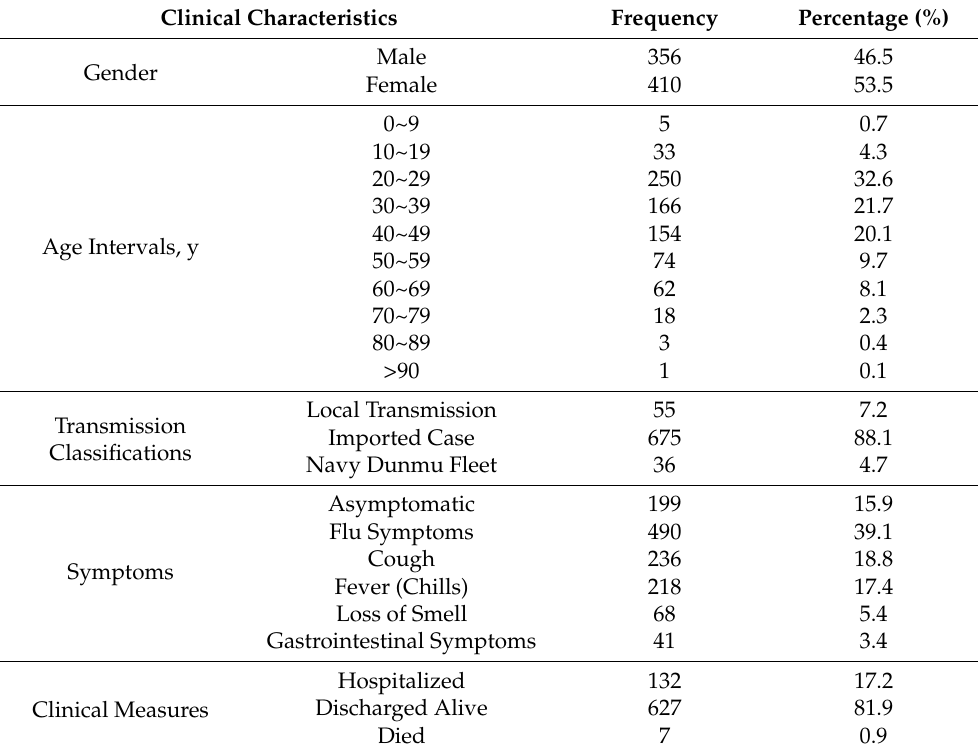
Table 1. Epidemiology characteristics of confirmed cases of COVID-19; N =